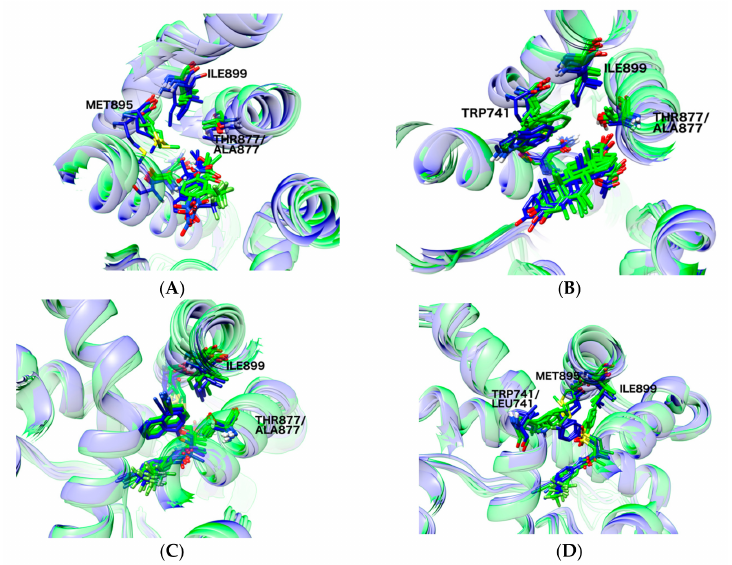
Figure 5. Cluster centroids from 100 ns MD simulation of four different ligands bound to mutated (agonist activity) and wild type (antagonist activity) AR. The structures from the mutated structures are depicted in blue, the WT structures in green. PDB IDs: ( A ) 2AX6; ( B ) 2OZ7; ( C ) 3RLL; ( D )